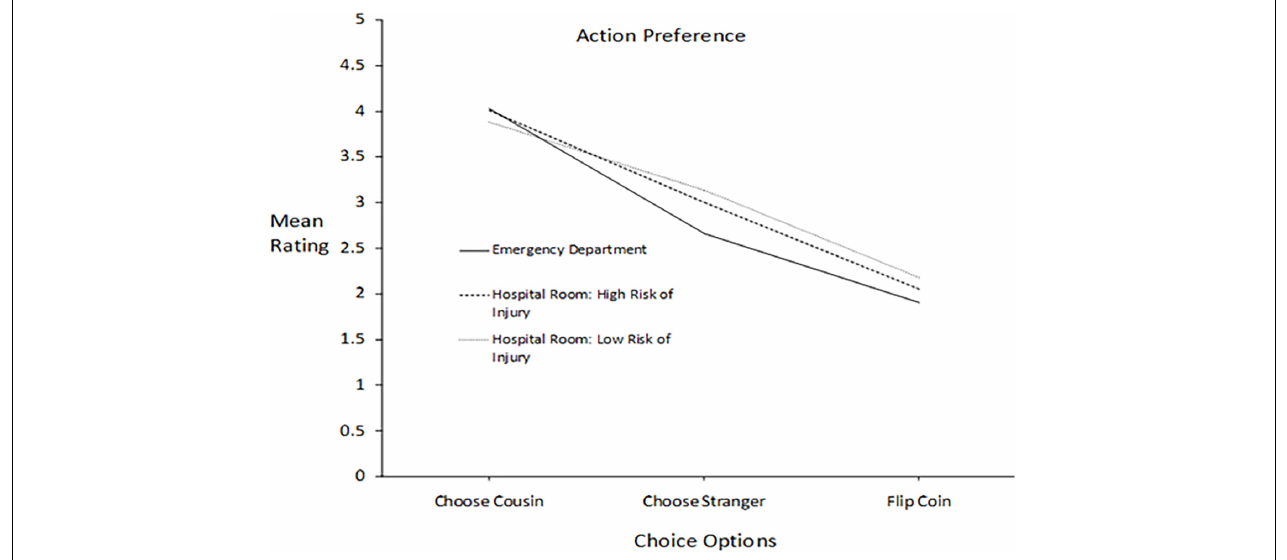
FIGURE 4 | For patients differing in kinship relationship to the participants (cousin vs. stranger), mean ratings of three courses of action in three settings differing in severity of risk to the patients: death, high risk of injury, and lower risk of injury.